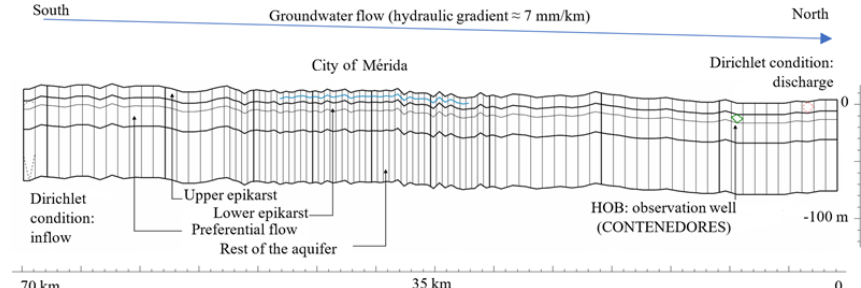
Figure 8. Layer discretization for the MMA subsurface. Modified after Martínez-Salvador et al. (2019).